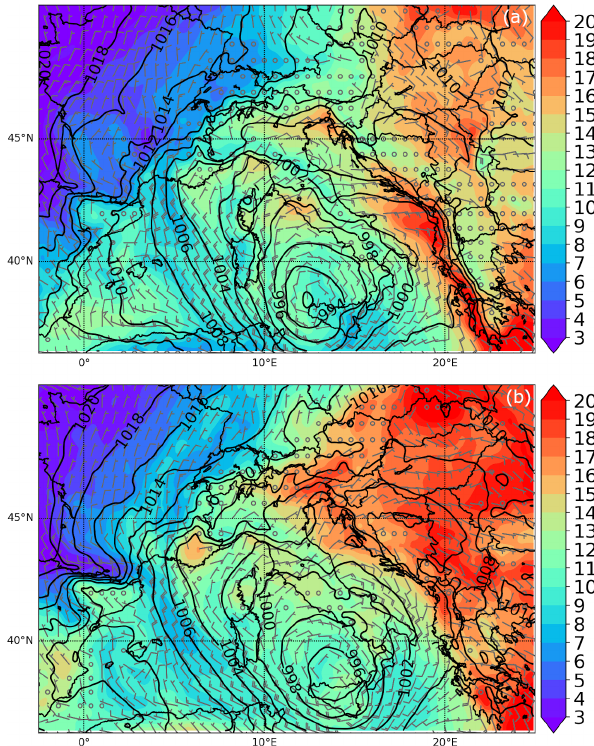
Figure 2. ECMWF analyses: 850hPa temperature ( ◦ C), wind field (wind barbs) at 950hPa and sea level pressure (black lines) on 3 May at 6:00UTC (a) and 12:00UTC (b)